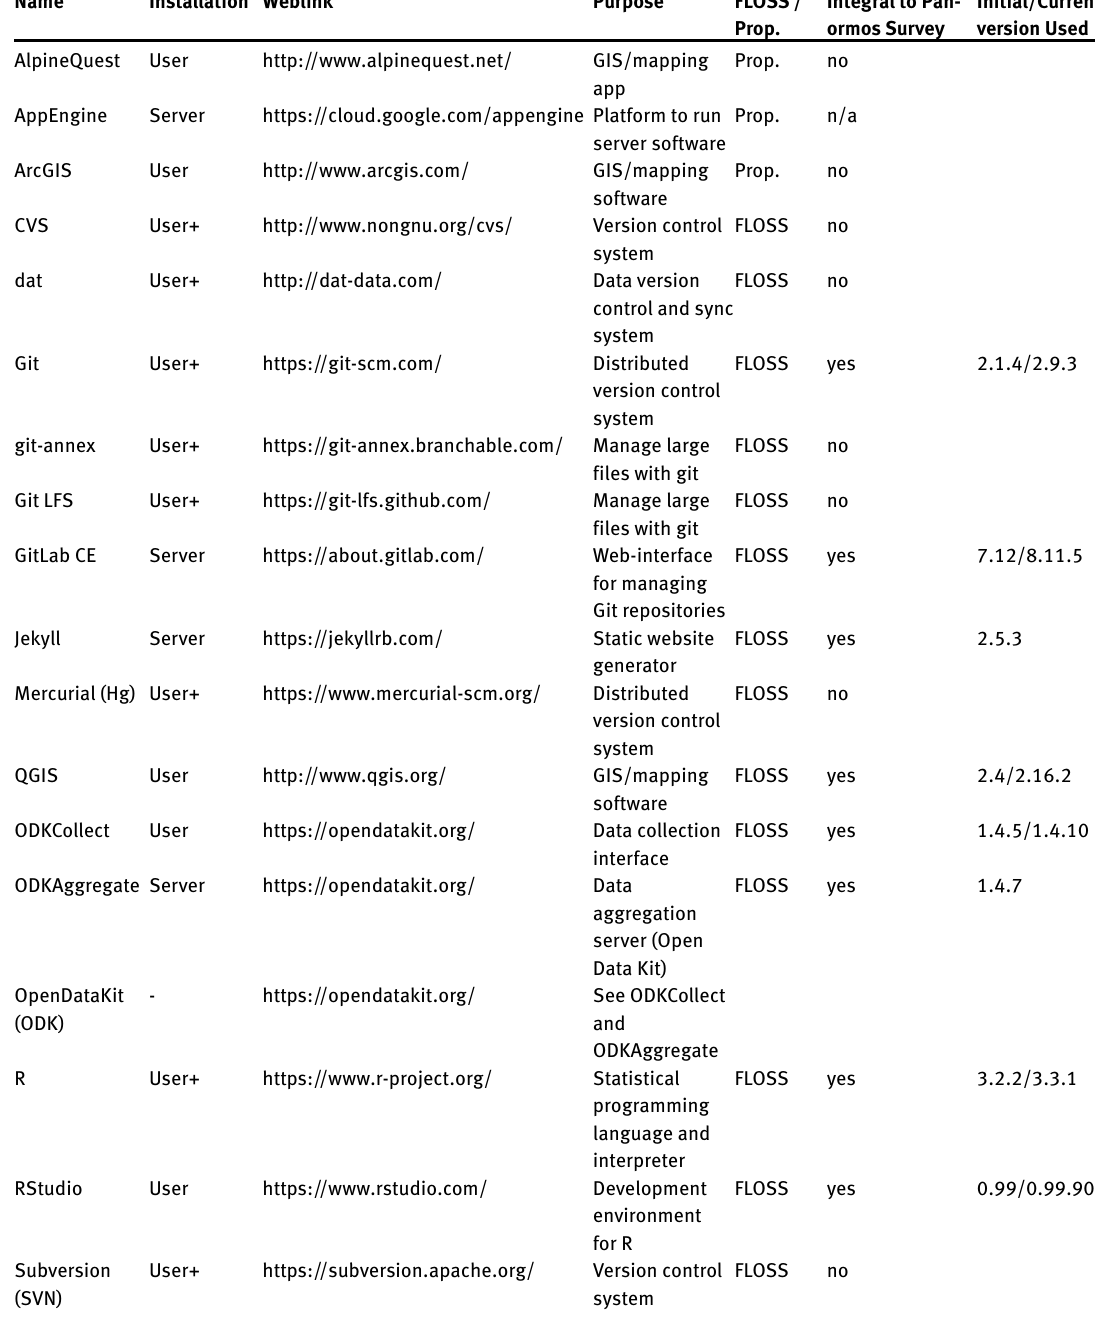
Table 1. Software and